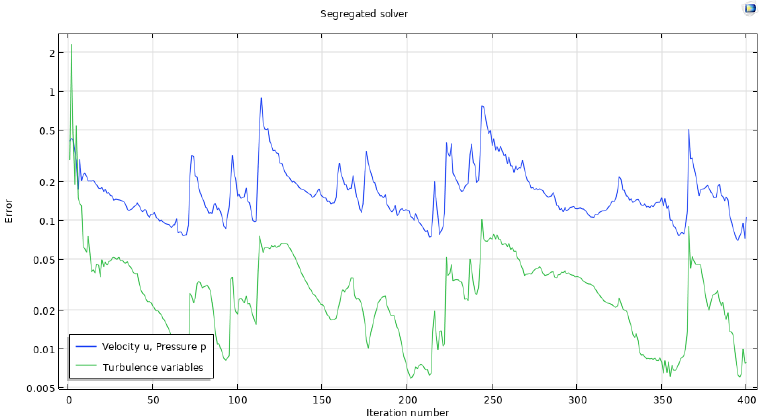
Figure 8. Model 5: Fuel inlet velocity 70 m/s. Viscosity 1.8 × 10 − 5 Pa·s. Model 6: artificial diffusion was used to achieve convergence. The isotropic diffusion